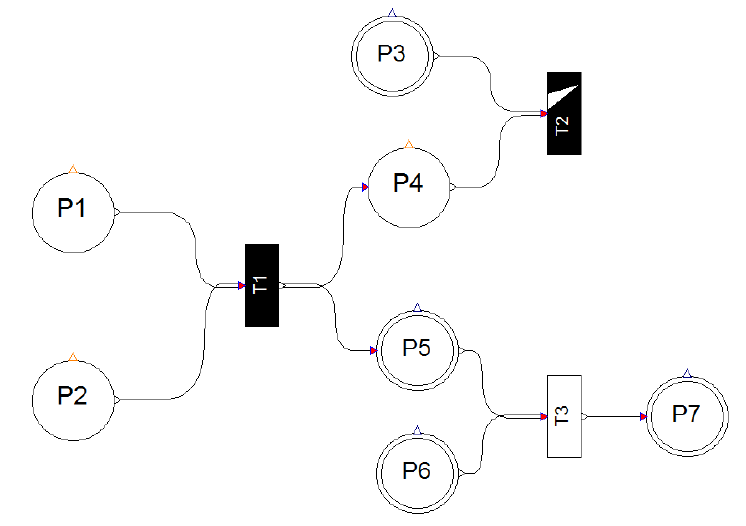
Figure 6: Hybrid Petri Net modeled by the Petri Net library in Dymola where P1, P2, P4 and T1 are discrete, T2 is stochastic and P3, P5, P6, P7 and T3 are continuous Petri Net elements.